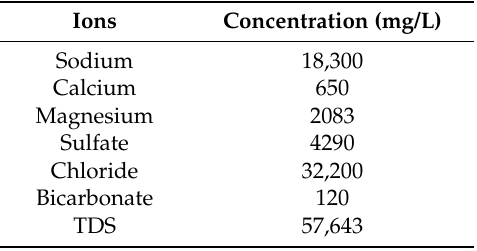
Figure 1. The structure of the surfactants used in this study. Table 1. The composition of the synthetic seawater used in this study [39].